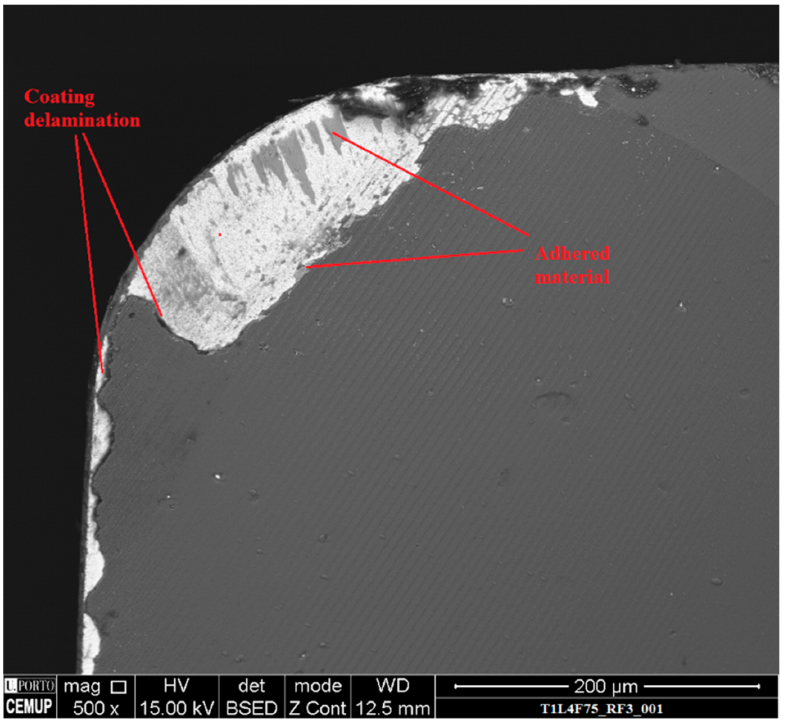
Figure 8. Rake face, with a 500 × magnification, of the T1L4F75 tested tool, with wear mecha- nism